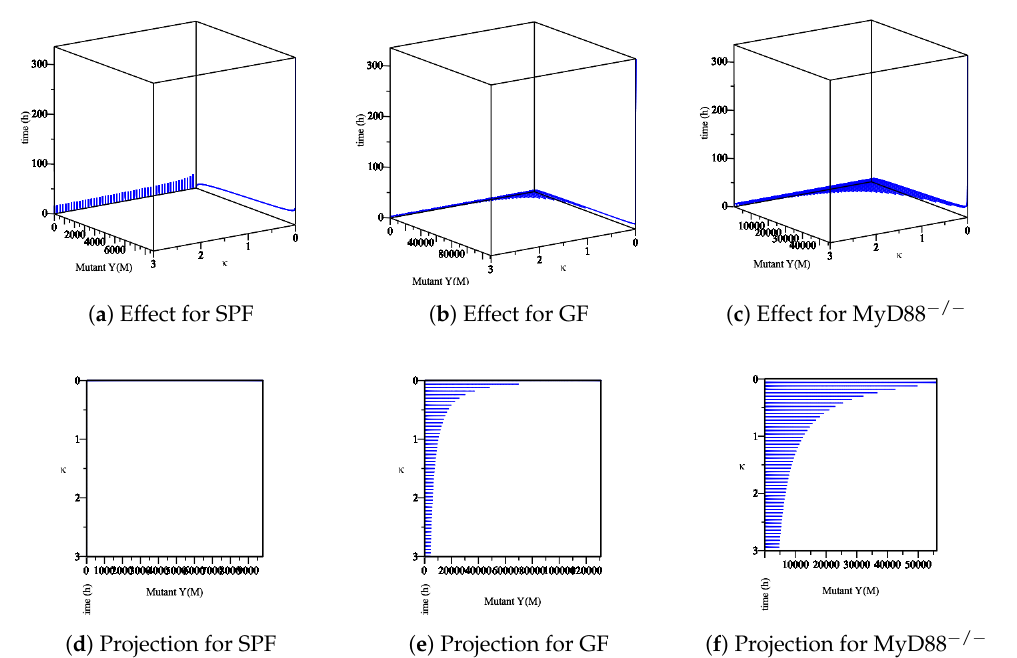
Figure 8. The sensitivity of parameter κ in the elimination of mut Yersinia strain in the mucosa. ( a – c ) The effect of the parameter κ on the different types of mice. ( d – f ) The projection of κ for different types of